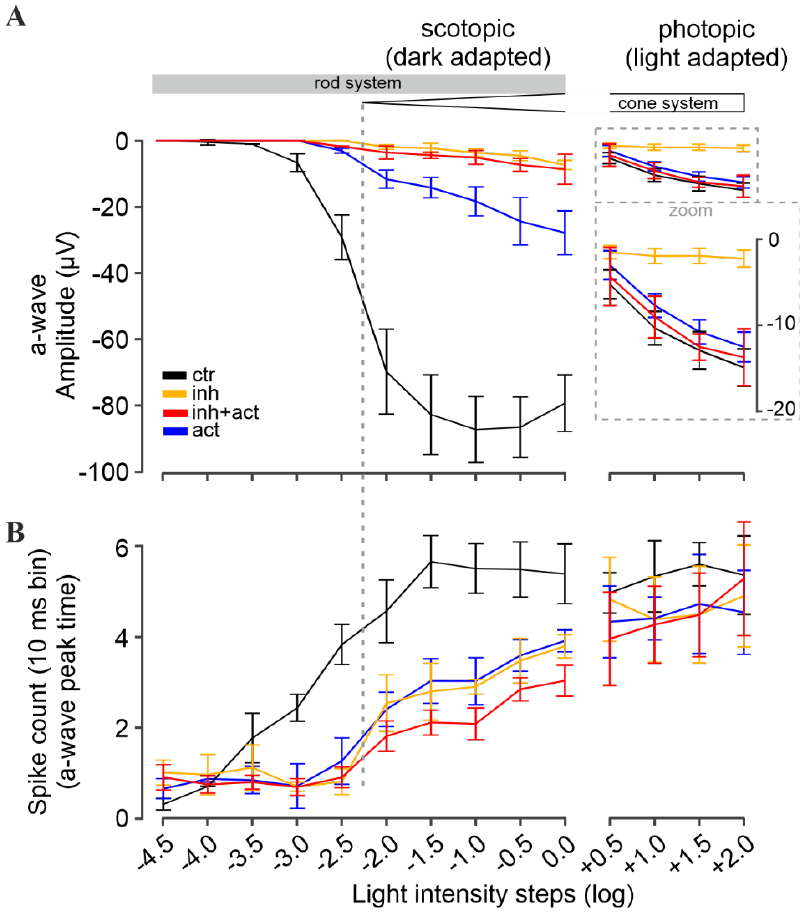
Figure 6. Modulation of retinal light responses by cGMP analogues. Retinal function was measured under scotopic (dark-adapted, left panel) and photopic (light-adapted, right panel) conditions, reflecting rod and cone function, respectively. ( A ) Light-flash-mediated photoreceptor responses shown as a-wave peak amplitudes, and ( B ) correlated retinal ganglion cell spike responses shown as counts per 10 ms bin. Experimental conditions: control (black), inhibitor (Rp-8-Br-PET-cGMPS, 50 µM, orange), activator (8-pCPT-cGMP, 0.1 µM, blue), and inhibitor and activator co-application (red, 50 µM and 0.1 µM, respectively). n = 5 retinae for each condition. Data shown averaged from 30 MEA recording electrodes, per condition. See Figures S3 and S4 for the respective µ ERG trace and spike data, and Tables S2 and S3 for all values and statistical